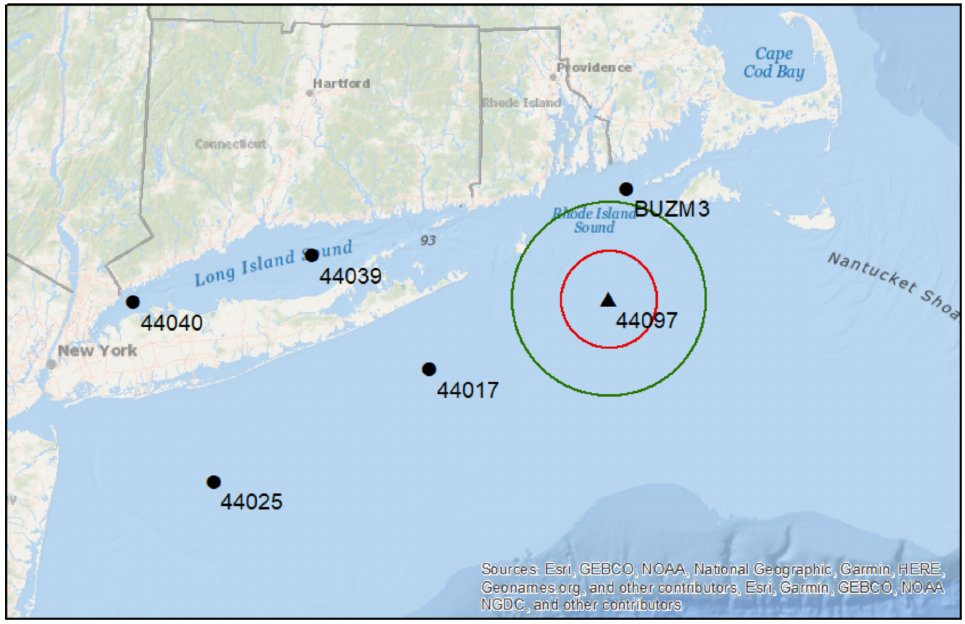
Figure 1. Locations of buoy sensors measuring wind speed and H s , as well as the BUZM3 wind tower station. Data are displayed in a coordinate system in which units are in degrees, and where degrees are represented as equally spaced over the x and y scale. The red bound and green bound represent 0.25 and 0.5 decimal degree radii from a buoy. Buoys are displayed either as a circle or triangle to show whether they are within or outside of 50 km from land,